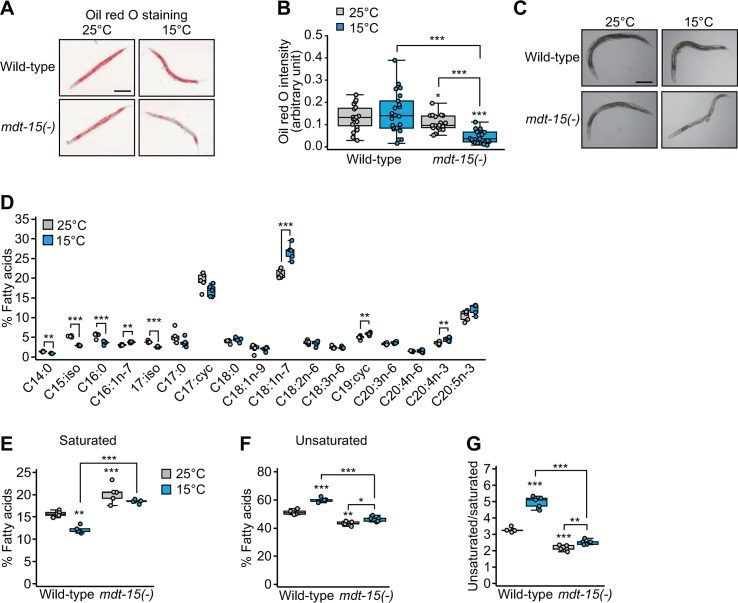
MDT-15 maintains overall fat levels and UFA/SFA ratios at low temperatures.(A) Oil red O signals represent overall fat levels in wild-type and mdt-15(tm2182) [mdt-15(-)] mutant animals at 25 °C and 15 °C. Scale bar: 200 μm. (B) Quantification of the Oil red O staining in panel A (two-tailed Student t tests, ***p < 0.001, n ≥ 20 from three independent experiments). (C) Bright-field images of wild-type and mdt-15(-) mutant animals at 25 °C and 15 °C. mdt-15(-) mutants displayed pale intestines at 15 °C. The images were obtained when the worms reached day 1 adult stage. Scale bar: 200 μm. (D) Total fatty acid composition in wild-type animals at 25 °C and 15 °C was analyzed by using GC/MS (n = 5). Fractions of each fatty acid in the total fatty acids (mole/mole) were calculated. (E, F) Fractions of SFAs (E) and UFAs (F) in wild-type and mdt-15(-) mutant animals at 25 °C and 15 °C. These results are consistent with the effect of mdt-15(-) on fatty acid composition at 20 °C [42]. (G) The ratios of UFAs/SFAs that were calculated from panels E and F (two-tailed Student t tests, *p < 0.05, **p < 0.01, ***p < 0.001, n = 5). See S7 Table for the standard deviations of box plot data. cyc, cyclo; GC/MS, gas chromatography/mass spectrometry; iso, isomer; MDT-15, Mediator 15; SFA, saturated fatty acid; UFA, unsaturated fatty acid.